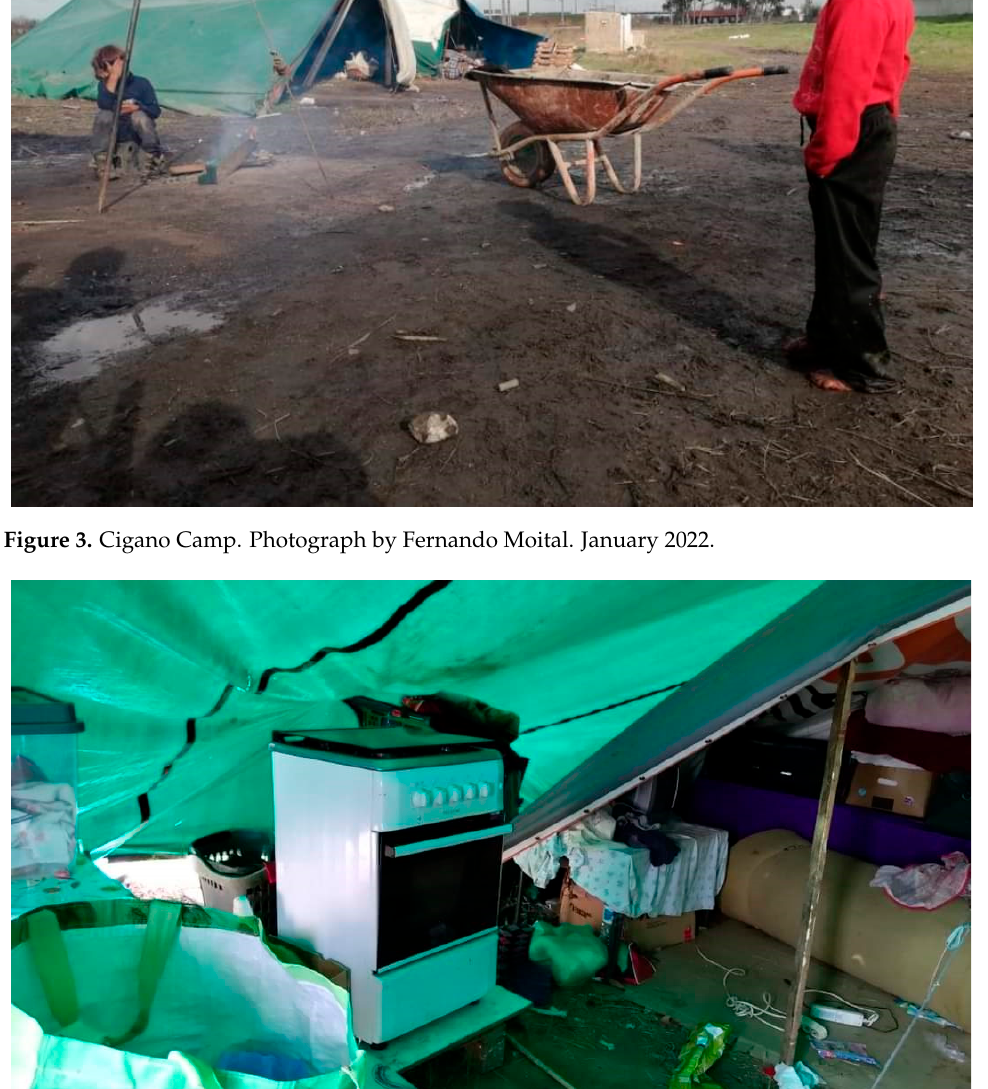
Figure 4. Inside the tarps. Photograph by Fernando Moital. January 2022.